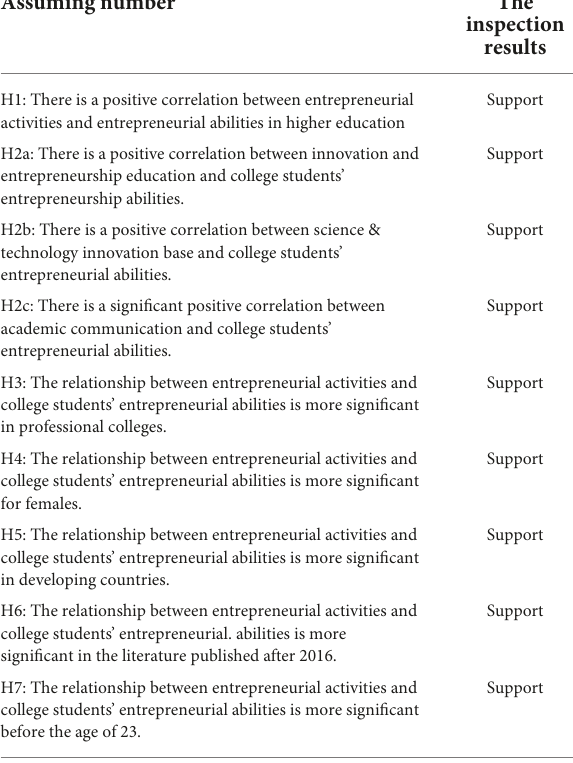
TABLE 5 Total summary results of the theoretical